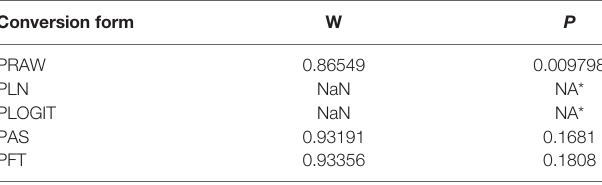
TABLE 1 | Normal distribution test for the normal rate and the different conversion of the normal rate. Conversion form W P